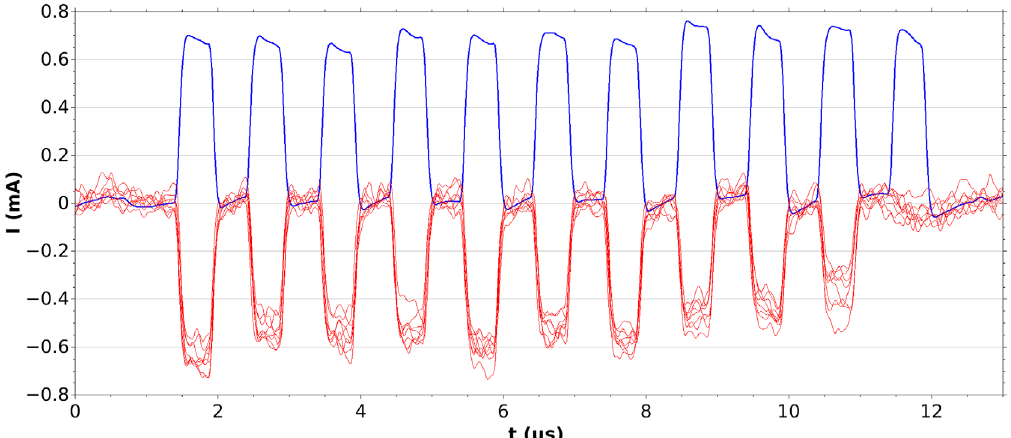
FIG. 23. The experimental results. The average beam current for the H − pulse measured by the BCM at the interaction point before stripping (blue curve) and eight separately measured stripped proton beam shots on the same beam current monitor during stripping (red curve). This figure is reproduced from Ref.